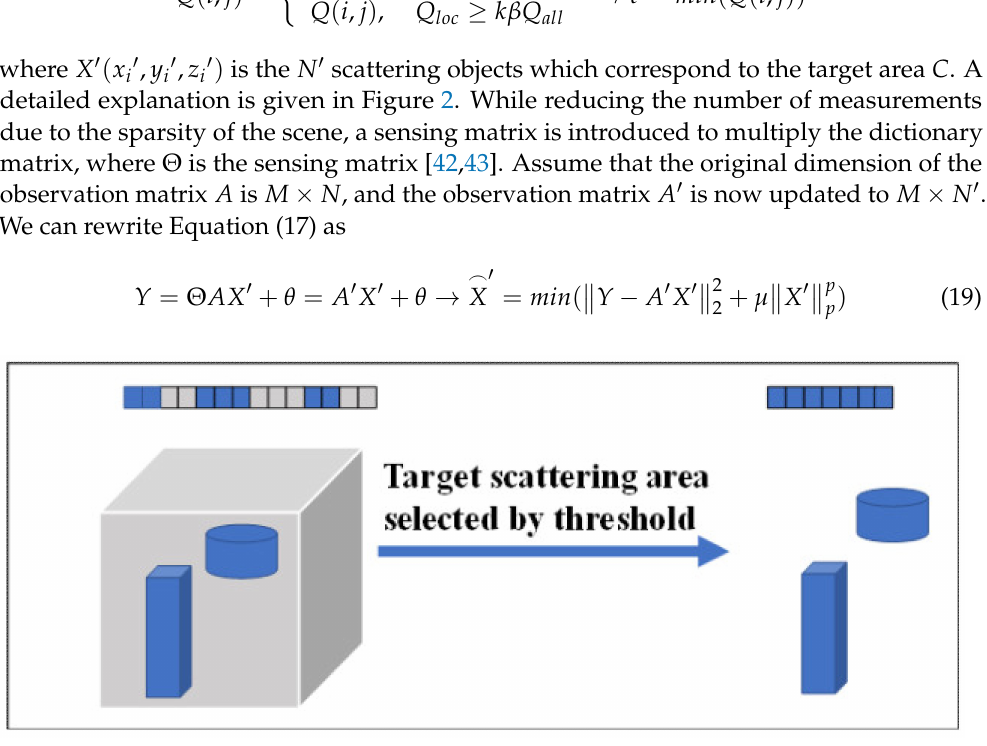
Figure 2. The target scattering area selection